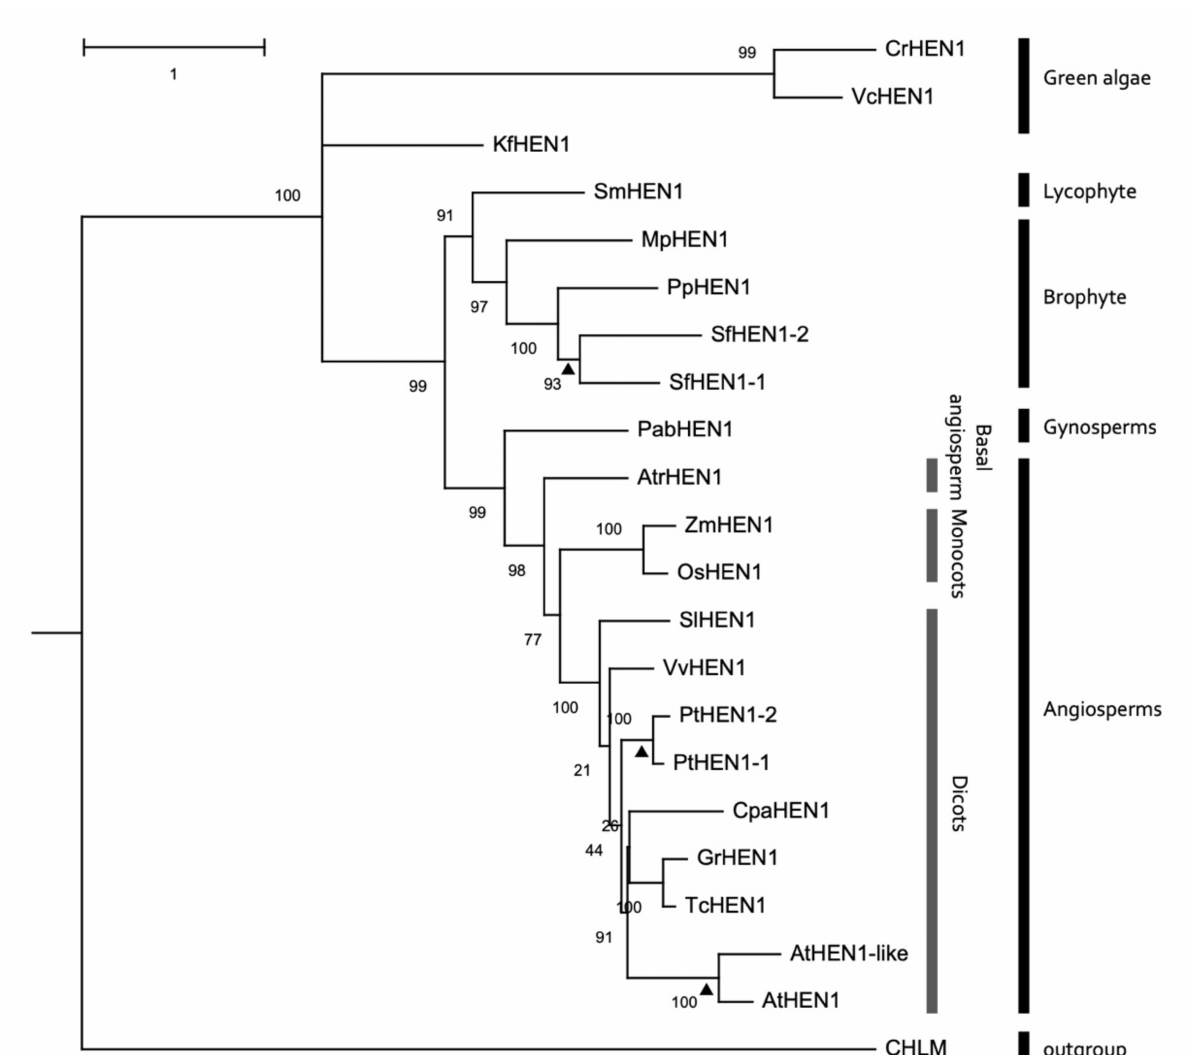
Figure 8. Phylogenetic tree of HEN1 and HEN1 orthologs of different species of plant kingdom. Maximum likelihood (ML) tree of 22 HEN1 orthologs of green plants. MAGNESIUM-PROTOPORPHYRIN IX METHYLTRANSFERASE (CHLM) of Arabidopsis was used as the outgroup. Abbreviation of species names: Sm, Selaginella moellendorffii (Smoe109211); At, Arabidopsis thaliana (AT4G20910); Arabidopsis thaliana (AT4G20920); Os, Oryza sativa (BAJ16352); Atr, Amborella trichopoda (evm_27.model.AmTr_v1.0_scaffold00092.83); Pab, Picea abies (PAB00043215); Mp, Marchantia polymorpha (Mp3G16010); Pp, Physcomitrella patens (Pp3c1_60V3.4); Kf, Klebsormidium flaccidum (kfl00033_0220_v1.1); Cr, Chlamydomonas reinhardtii (Cre03.g191200); Vc, Volvox carteri (Vocar.0035s0143.1); Zm, Zea mays (GRMZM2G107457_T01); Sf, Sphagnum fallax (Sph- falx0066s0042.1, Sphfalx0001s0228.1); Sl, Solanum lycopersicum (Solyc02g070030.2.1); Pt, Populus trichocarpa (Potri.001G465500, Potri.011G163600); Gr, Gossypium raimondii (Gorai.010G144100); Tc, Theobroma cacao (Thecc1EG026937); Cpa, Carica papaya (evm.model.supercontig_166.41), Vv, Vitis vinifera (GSVIVG01021670001) and Arabidopsis thaliana , CHLM (AT4G25080). The bootstrap values are shown above the branches at the nodes. Arrowheads indicate duplicated